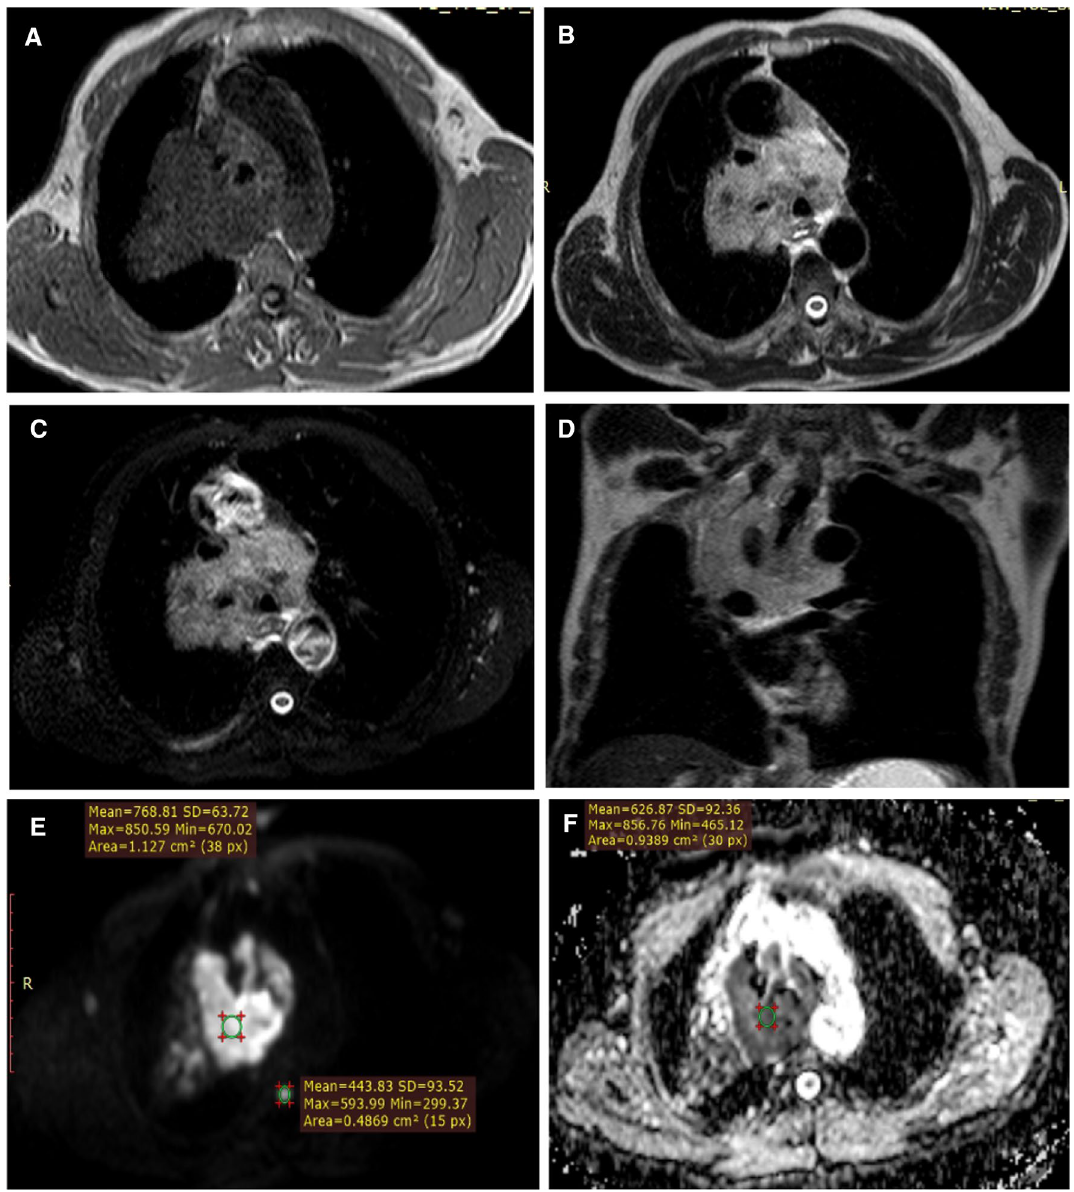
Fig. 1 63‑year‑old male patient presenting with massive weight loss, cachexia and hoarseness of voice. Axial T1 ( A ), axial T2 ( B ), axial STIR ( C ) and coronal T2 STIR ( D ) weighted MR images show large right upper lobar soft tissue mass lesion measuring 6 and craniocaudal dimensions respectively. It elicits isointense signal and hyperintense signal relative to the surrounding muscles on T1 and T2. It shows right hilar and mediastinal extensions encroaching on the lumen of the trachea and right main bronchus with obstruction of the upper lobar bronchus causing subsequent partial collapse of the right upper lobe. It is seen abutting the SVC. DWI ( E ) and ADC map ( F ) images show restricted diffusion with LSR 1.73, ADC mean 0.63 and ADC min 0.46. Histopathology revealed small cell lung =